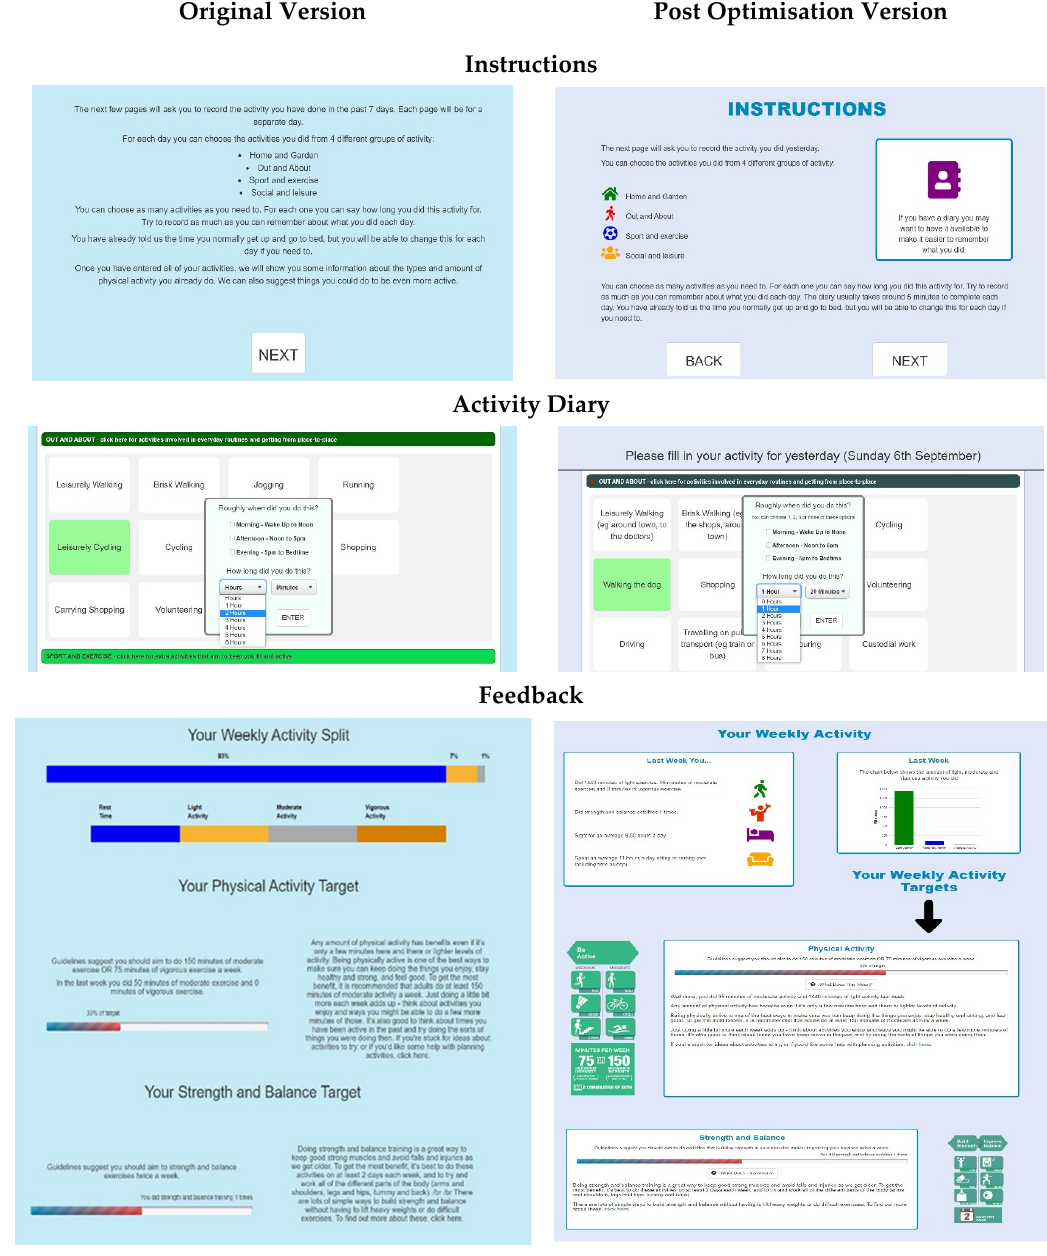
Figure 3. Screenshots from the My Activity Diary tool: original and post think aloud